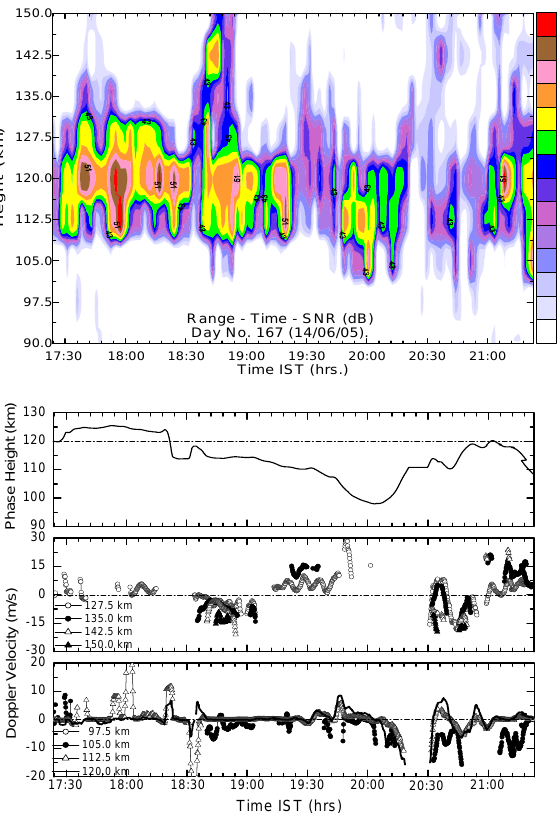
Fig. 4. Same as Fig. 2 except for the Day no. 249, 2005 (6 Septem- ber 2005).